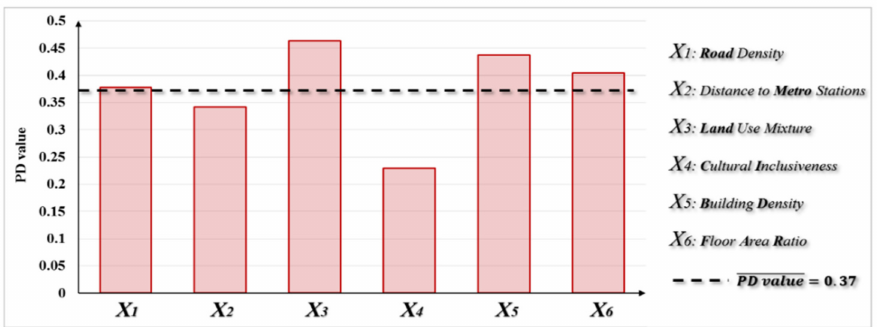
Figure 7. Individual effect of determinants on